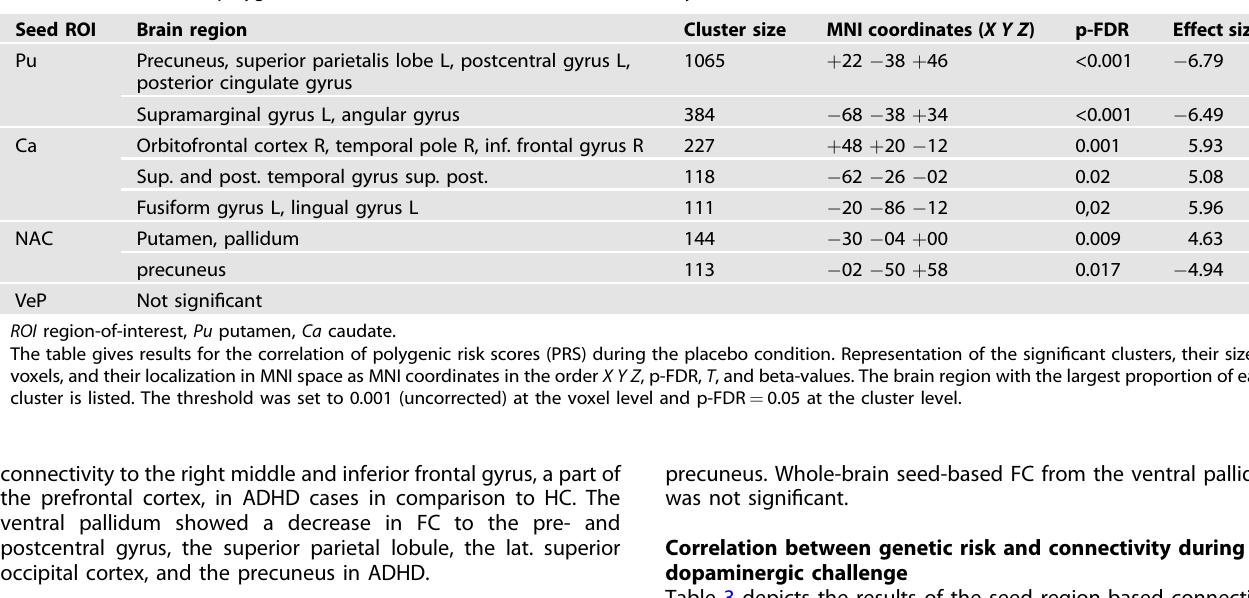
Correlation between genetic risk and connectivity during the dopaminergic challenge Table 3 depicts the results of the seed region-based connectivity analysis of the comparison between ADHD and controls. A graphical overview is available in Fig. 2 (right column). The putamen demonstrates a pronounced reactivity to L-DOPA. In participants with a high genetic load, the connectivity between putamen, the superior parietal lobe, and the precuneus was increased by L-DOPA. This was not found for the caudate as a seed region. The nucleus accumbens demonstrated a wide loss in connectivity for a range of clusters from right Insula, occipital lobe, and frontal medial gyrus. These areas are part of the salience network and present with a decreased connectivity during L- DOPA-challenge in those patients with a higher genetic risk. The ventral pallidum demonstrated a decrease in FC to the precentral gyrus in those individuals with a higher genetic risk. For evaluation of the PRS ’ speci fi city, we extracted the functional connectivity for each participant from the putamen – precuneus connectivity during the L-DOPA challenge. We correlated this with the individual PRS for schizophrenia, MDD, and body height. Neither schizophrenia PRS ( P = 0.23), MDD ( P = 0.29) nor body height